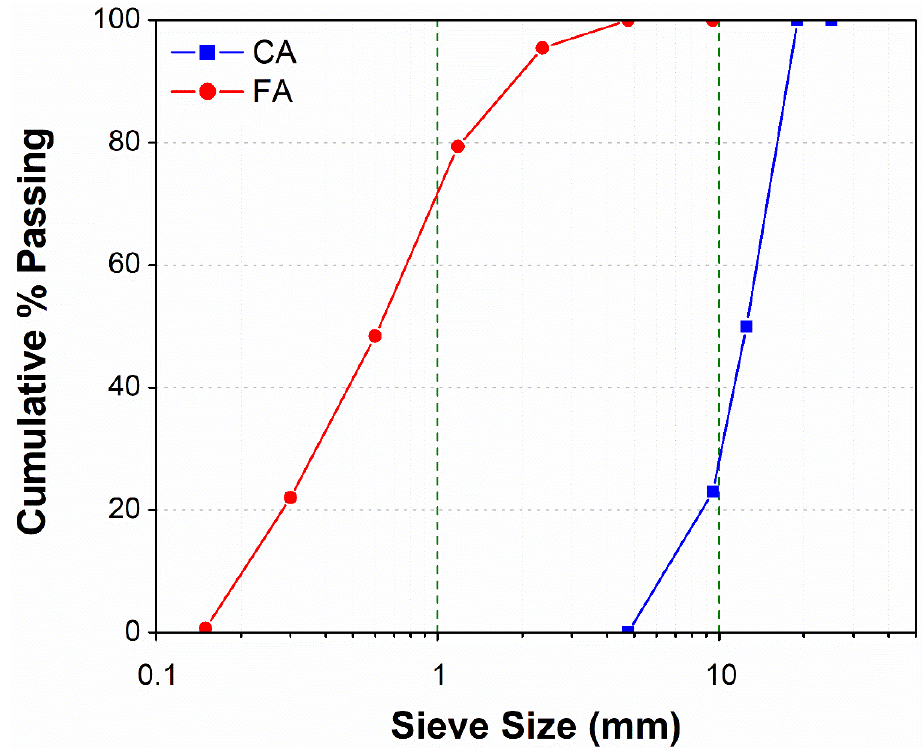
Figure 3. Grain size distribution of coarse and fine aggregates.